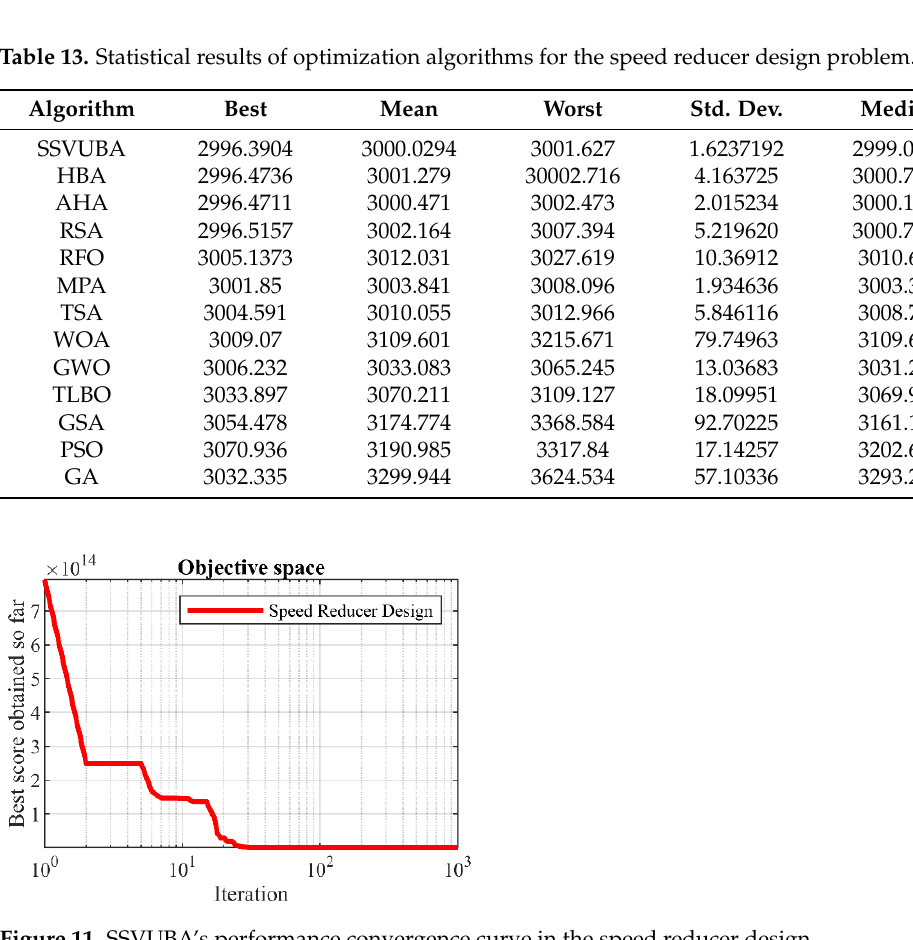
Figure 11. SSVUBA’s performance convergence curve in the speed reducer design.